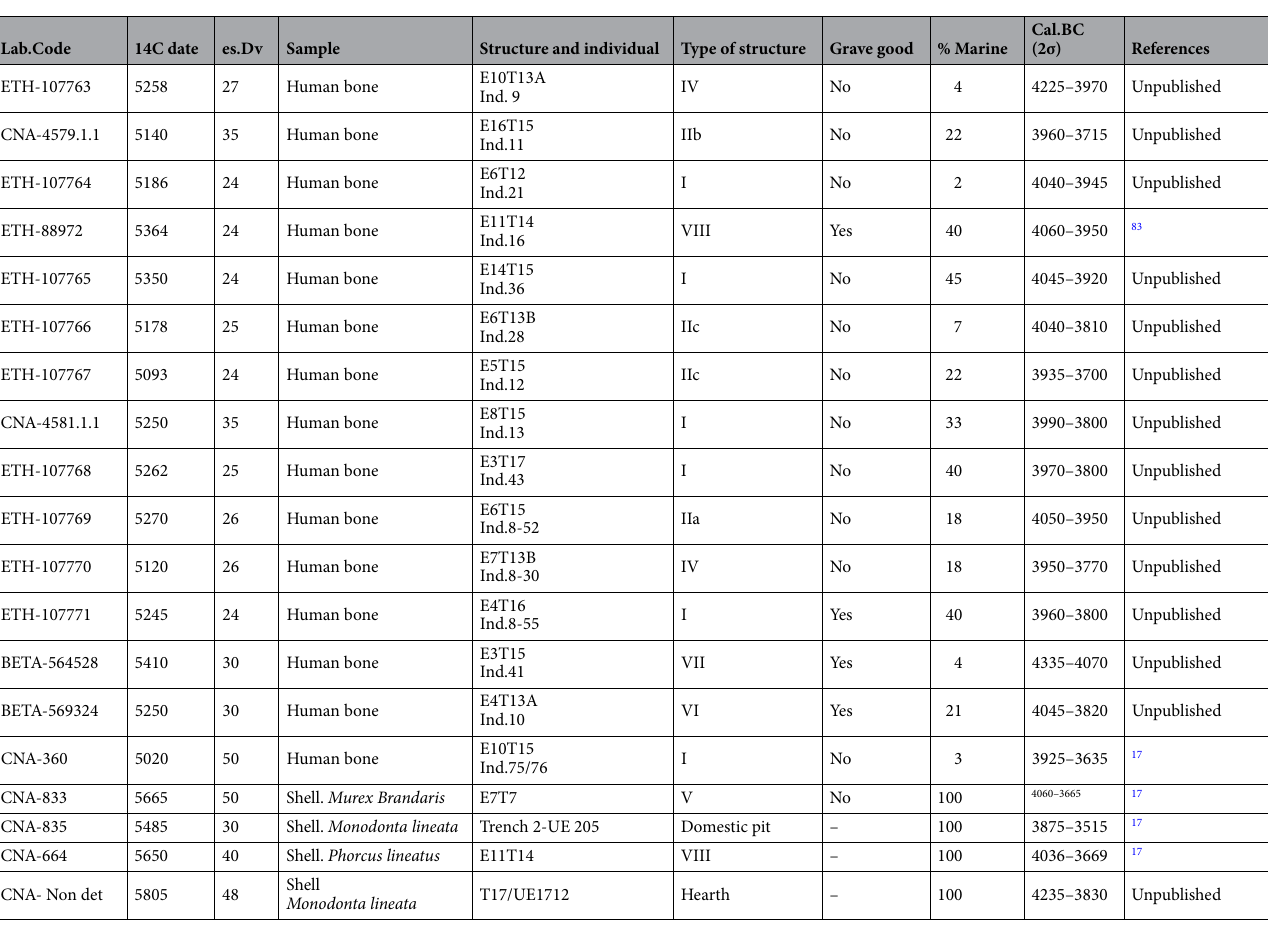
Table 2. Radiocarbon dates from the Campo de Hockey necropolis. The type of funerary structure, the presence/absence of grave goods and the calculated percentage of marine consumption are